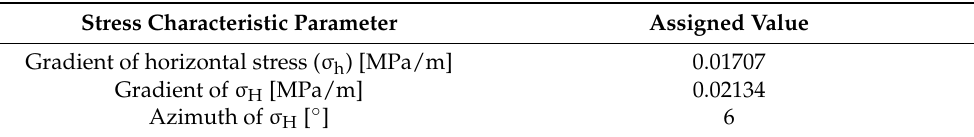
Table 2. Characteristics of regional principal horizontal stresses in the neighbouring area based on borehole breakouts (Jarosi´nski, 2006). Stress Characteristic Parameter Assigned